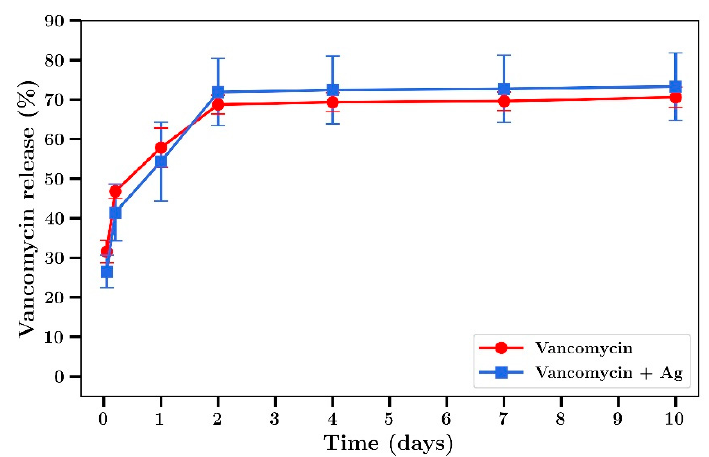
Figure 10. Time course of release of vancomycin from bone cement films containing vancomycin alone or vancomycin with Ag. (Silver loaded at 0.8% and vancomycin at 0.8% w/w ) ( n = 4).